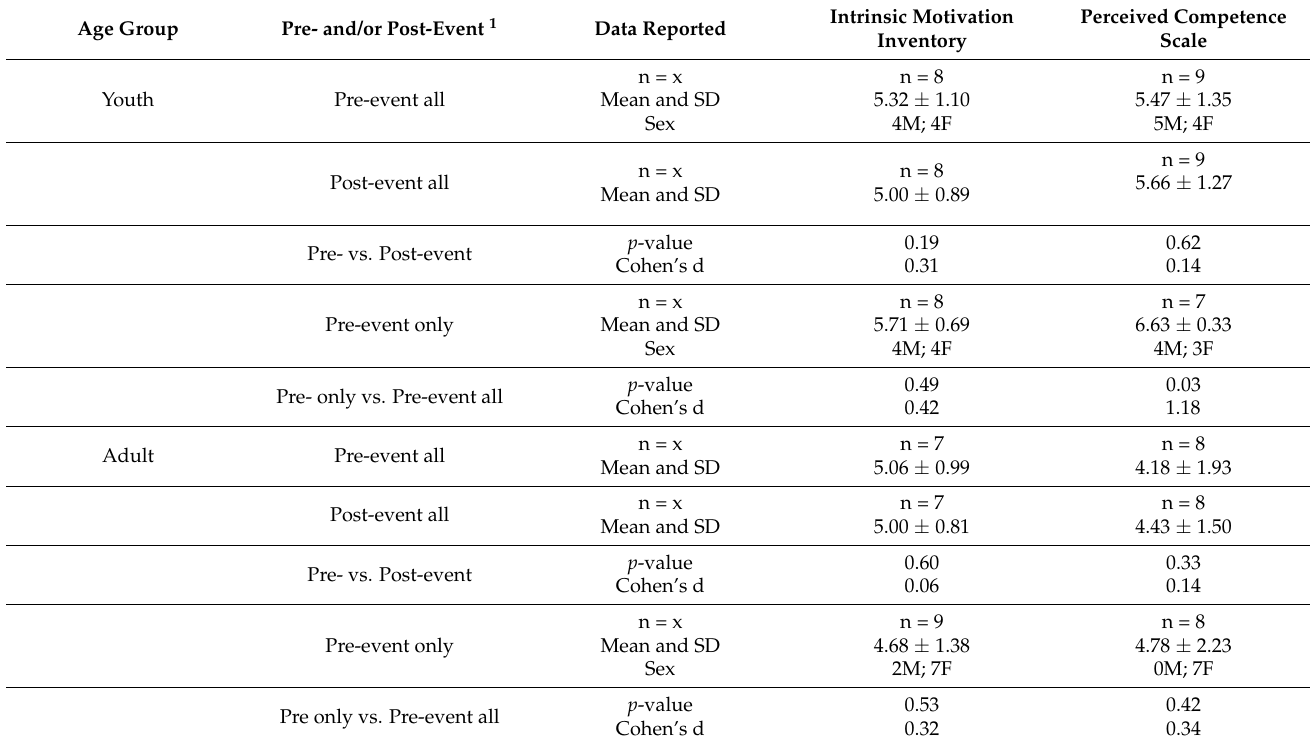
Table 2. Participants’ intrinsic motivation and perceived competence as reported by the intrinsic motivation inventory and the perceived competence scale.